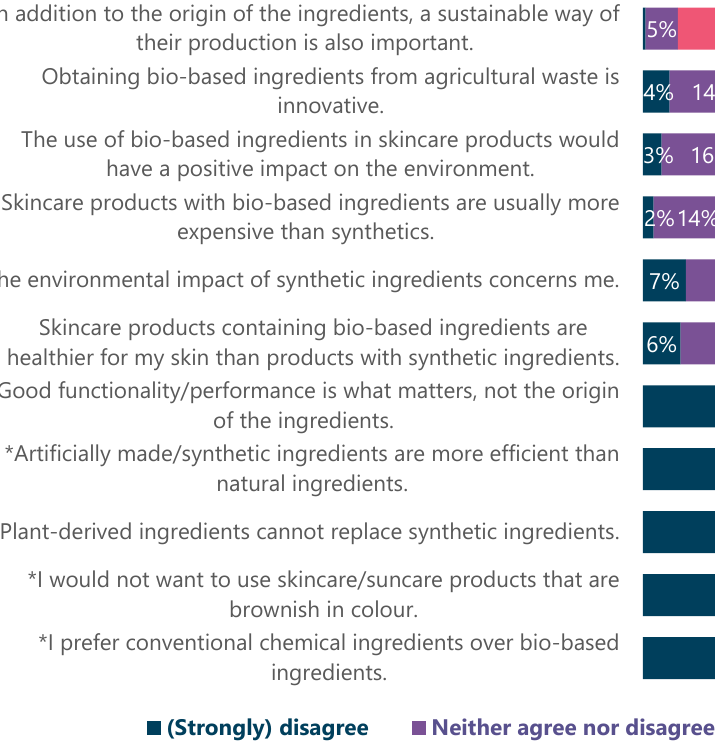
Figure 8. Attitude items with answer distribution from highest to lowest level of agreement (* represent a false claim). We also checked participants’ interest in skincare ( M = 3.91, SD = 1.00, Mdn = 4, IQR = 3–5), attitude towards their health ( M = 3.84, SD = 0.77, Mdn = 4, IQR = 3–4), and the environment ( M = 4.37, SD = 0.80, Mdn = 5, IQR = 4–5), using one item for each.